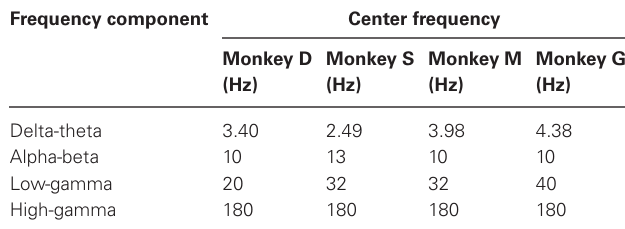
Table 1 | Center frequencies of the frequency components identified inter-saccade phase consistency for each of the